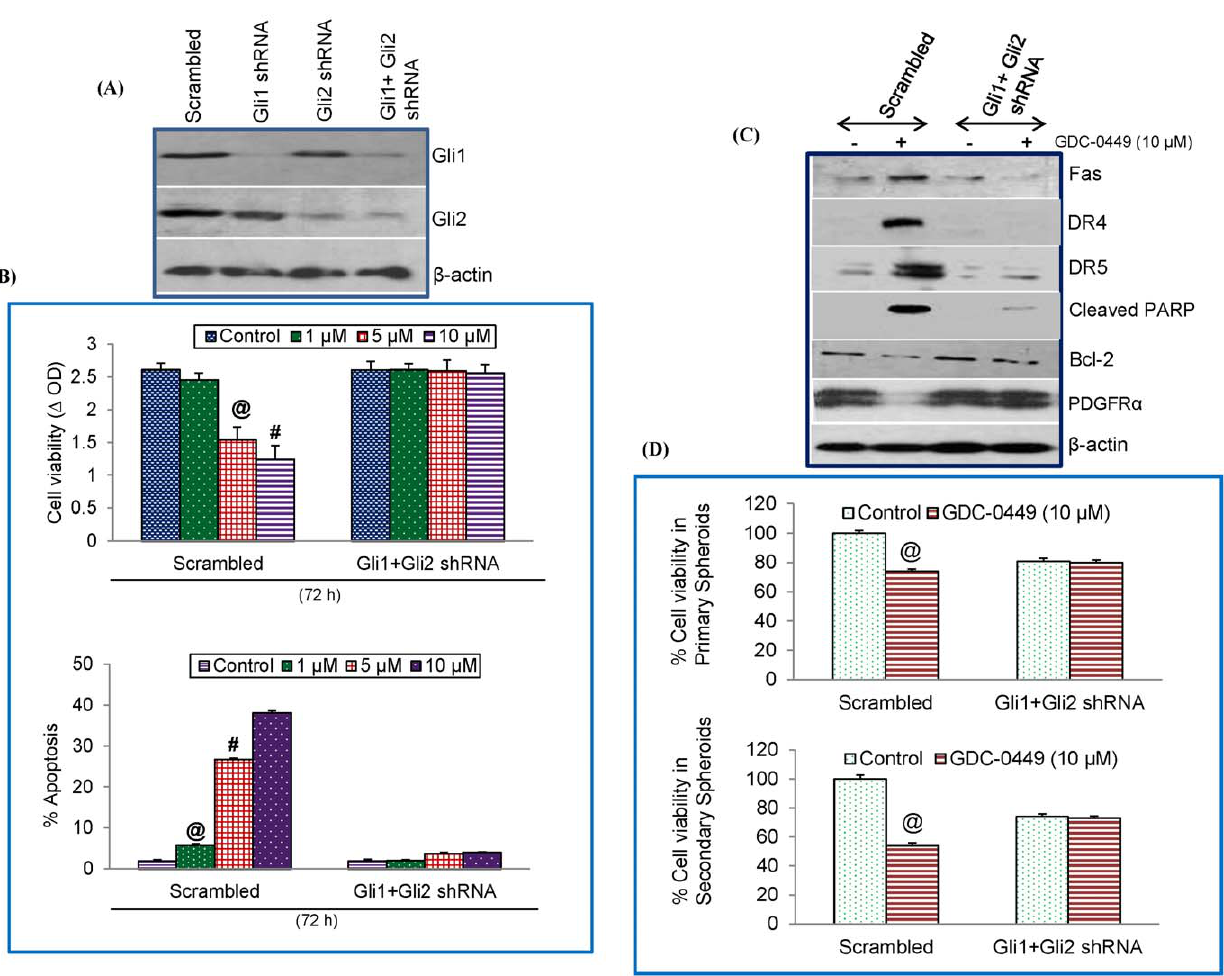
Figure 6. Impact of SHH signaling pathway on the regulation of cell survival and antiproliferative effects of GDC-0449 . (A), Knockout of Gli1 shRNA and Gli2 shRNA in human pancreatic CSCs. Pancreatic CSCs were transduced with lentiviral particles expressing Scrambled, Gli1 shRNA, Gli2 shRNA or Gli1 plus Gli2 shRNA (KO). (B), Pancreatic CSCs were treated with GDC-0449 (0, 1, 5 and 10 m M) for 72 h, and cell viability and apoptosis was measured in scrambled and Gli1 plus Gli2 shRNA CSCs. Data represent mean 6 SD, n=4. @ or # significantly different from respective control (P , 0.05). (C), Scrambled and Gli1 plus Gli2 shRNA pancreatic CSCs were treated with GDC-0449 (0 and 10 m M) for 48 h, and lysates were extracted to determine the expression of DR4, DR5, PDGFR a , Fas and Bcl-2 by Western blot analysis. b -Actin was used as the loading control. (D), Inhibition of primary and secondary spheroids by GDC-0449. Pancreatic CSCs (scrambled, and Gli1 + Gli2 shRNA) were seeded in suspension and treated with GDC-0449 (10 m M) for 7 days. At the end of incubation period, spheroids were collected, and dissociated with Accutase (Innovative Cell Technologies, Inc.). For secondary spheroids, cells were reseeded and treated with GDC-0449 (10 m M) for additional 7 days. Cell viability was measured by trypan blue assay. Data represent mean 6 SD. @ or # significantly different from respective controls, P ,